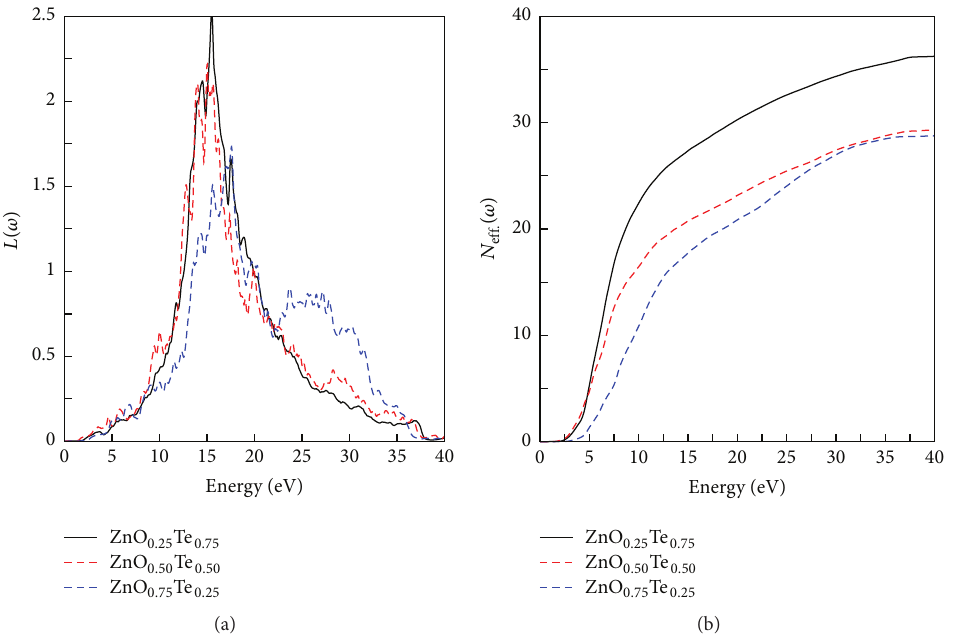
Figure 6: Frequency dependent (a) energy loss function and (b) oscillator